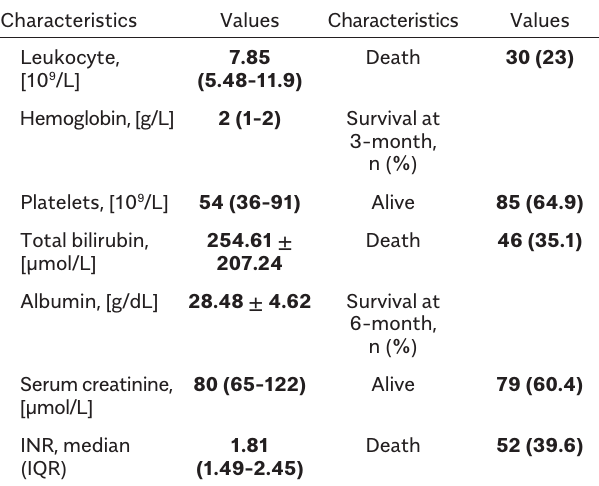
Table 1. Baseline Characteristics of Patients